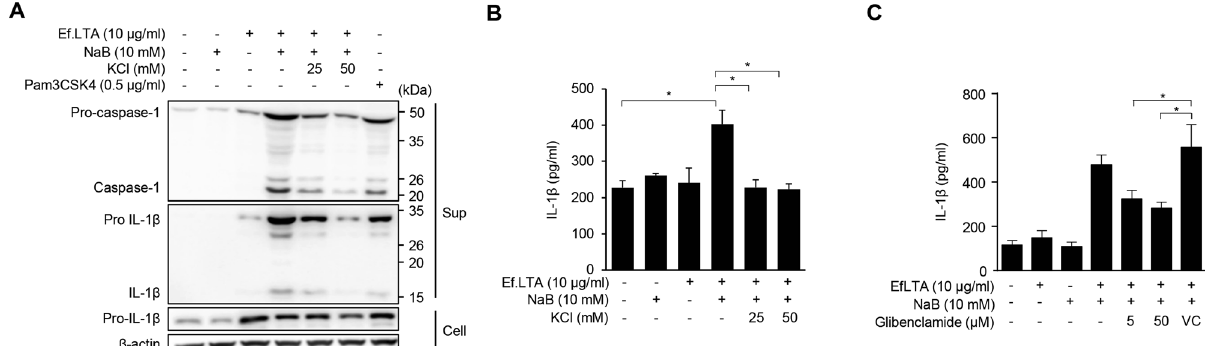
Fig. 5 K + ef fl ux is crucial for Ef.LTA/NaB-induced in fl ammasome activation. A PMA-differentiated THP-1 cells were pre-treated with or without 25 or 50 mM of potassium chloride (KCl) for 1 h and subsequently co-stimulated with Ef.LTA (10 μ g/ml) and NaB (10 mM) for 6 h. Then, the culture supernatants were collected and the levels of pro- or active caspase-1 and IL-1 β were determined by immunoblotting. B The concentrations of IL-1 β secreted into the culture supernatants were measured using ELISA. C The cells were pre-treated with glibenclamide (5 or 50 μ M) for 1 h and subsequently co-stimulated with Ef.LTA (10 μ g/ml) and NaB (10 mM) for an additional 6 h. IL-1 β expression in the culture supernatants was measured by ELISA. Pam3CSK4 was used as a positive control. VC denotes vehicle control (DMSO). * p < 0.05. The results shown are representative of triplicate experiments.